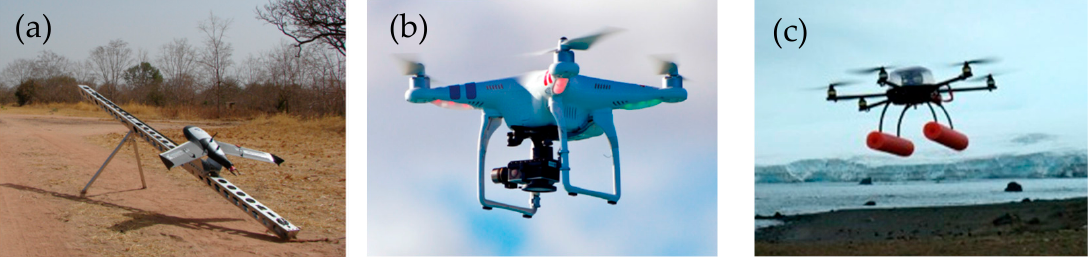
Figure 1. Photographs of representative UASs: ( a ) Gatewing × 100 TM , a fuel-powered fixed-wing UAS [43]; ( b ) DJI Phantom 2, an electric quadcopter [55]; and ( c ) APH-22, an electric hexacopter [57].